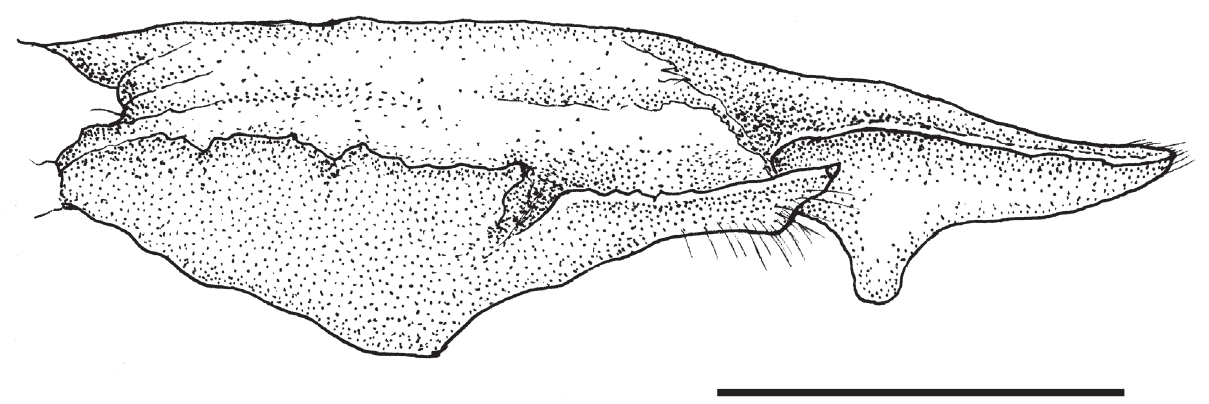
Figure 10. Aegla charon n. sp., male paratype (CL 18.11 mm; CLR 21.46 mm) (MZUSP 35194), subrostral process. Scale bar = 5.0